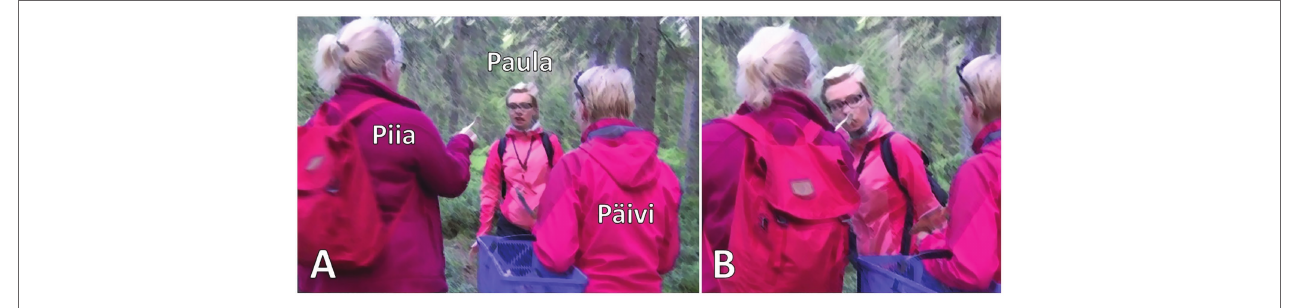
FIGURE 7 | Piia brings the mushroom under Paula’s nose (A) . Paula smells the mushroom, her gaze away from the mushroom and co-participants (B)